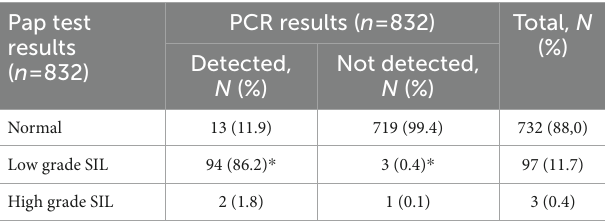
TABLE 3 Prevalence of hr HPV infection based on Pap test results in Ethiopian women. Pap test results